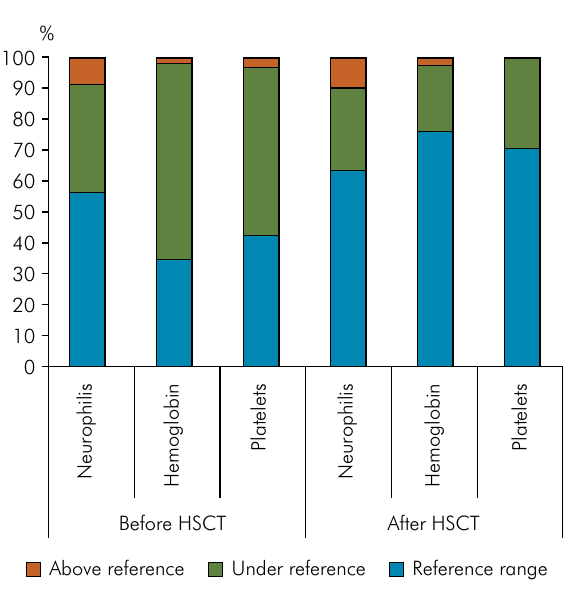
Figure 1. Complete blood results of individuals enrolled in the Program of Dental Care for Transplanted Patients,